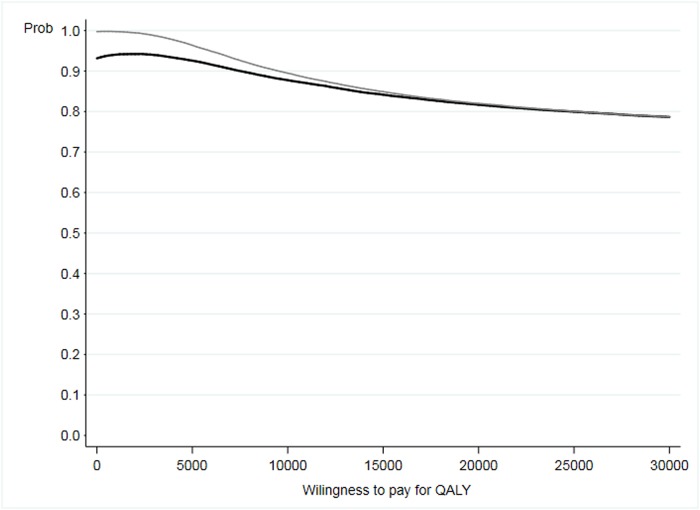
Cost-effectiveness acceptability curve.Grey line represents OSA-related costs and black line represents total costs.